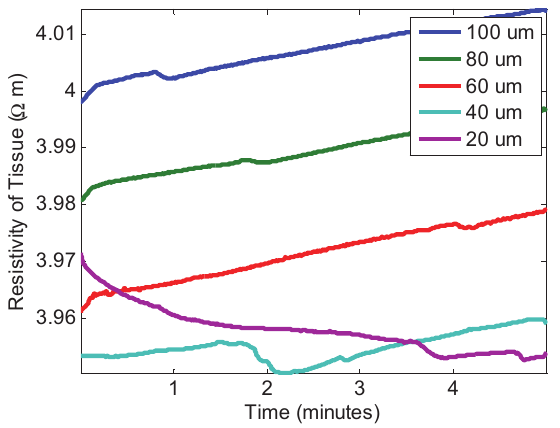
Fig. 15: Measured resistivity of alginate hydrogel encapsulated fibroblasts during small strain indentation experiments calculated from eq. 32. Legend denotes final indentation depth.